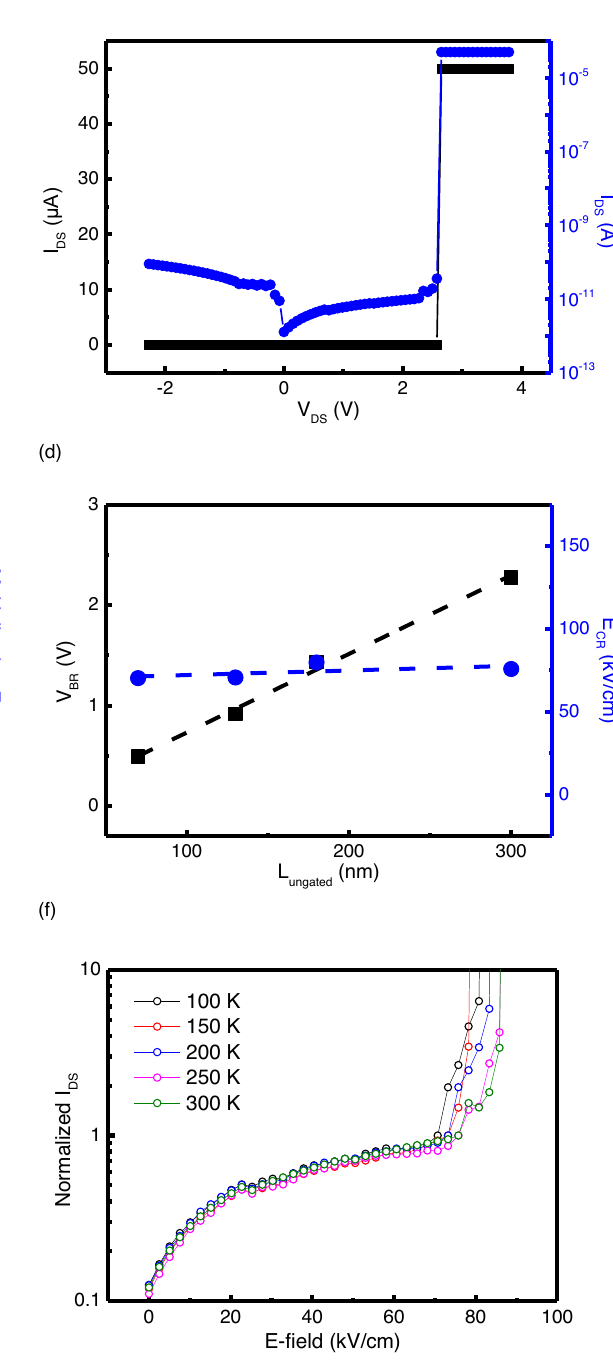
ungatedchannellengths.( V BR : V DS valueatwhichimpactionizationisinitiated, E CR : critical electric fi eld capable of generating impact ionization.). e E CR values extractedfromvariousI 2 FETswithdifferentenergybandgapsvs.numberoflayers. f Measured transfer characteristics as a function of electric fi eld for various